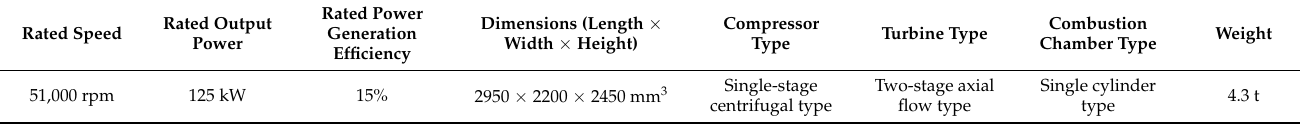
Figure 7. Experimental micro gas turbine unit. Table 4. Basic parameters of the micro gas turbine unit.